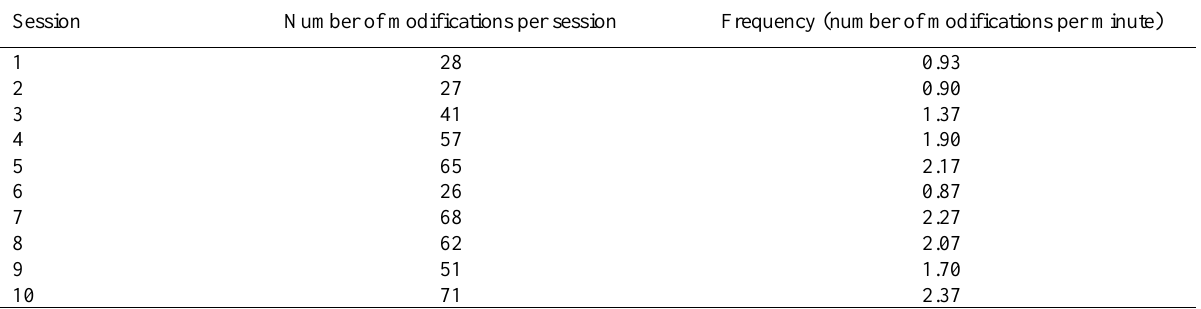
Number of Modifications Per Session and Frequency of Modifications* Session Number of modifications per session Frequency (number of modifications per